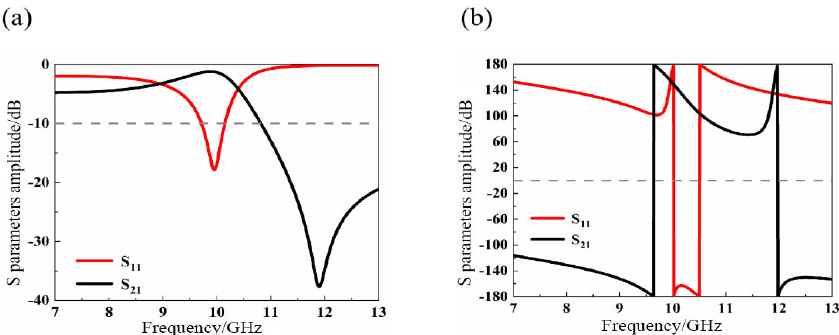
Figure 7. S-parameter curve of cascaded hexagonal ring-shaped structure ( a ) Amplitude graph; ( b ) Phase diagram.